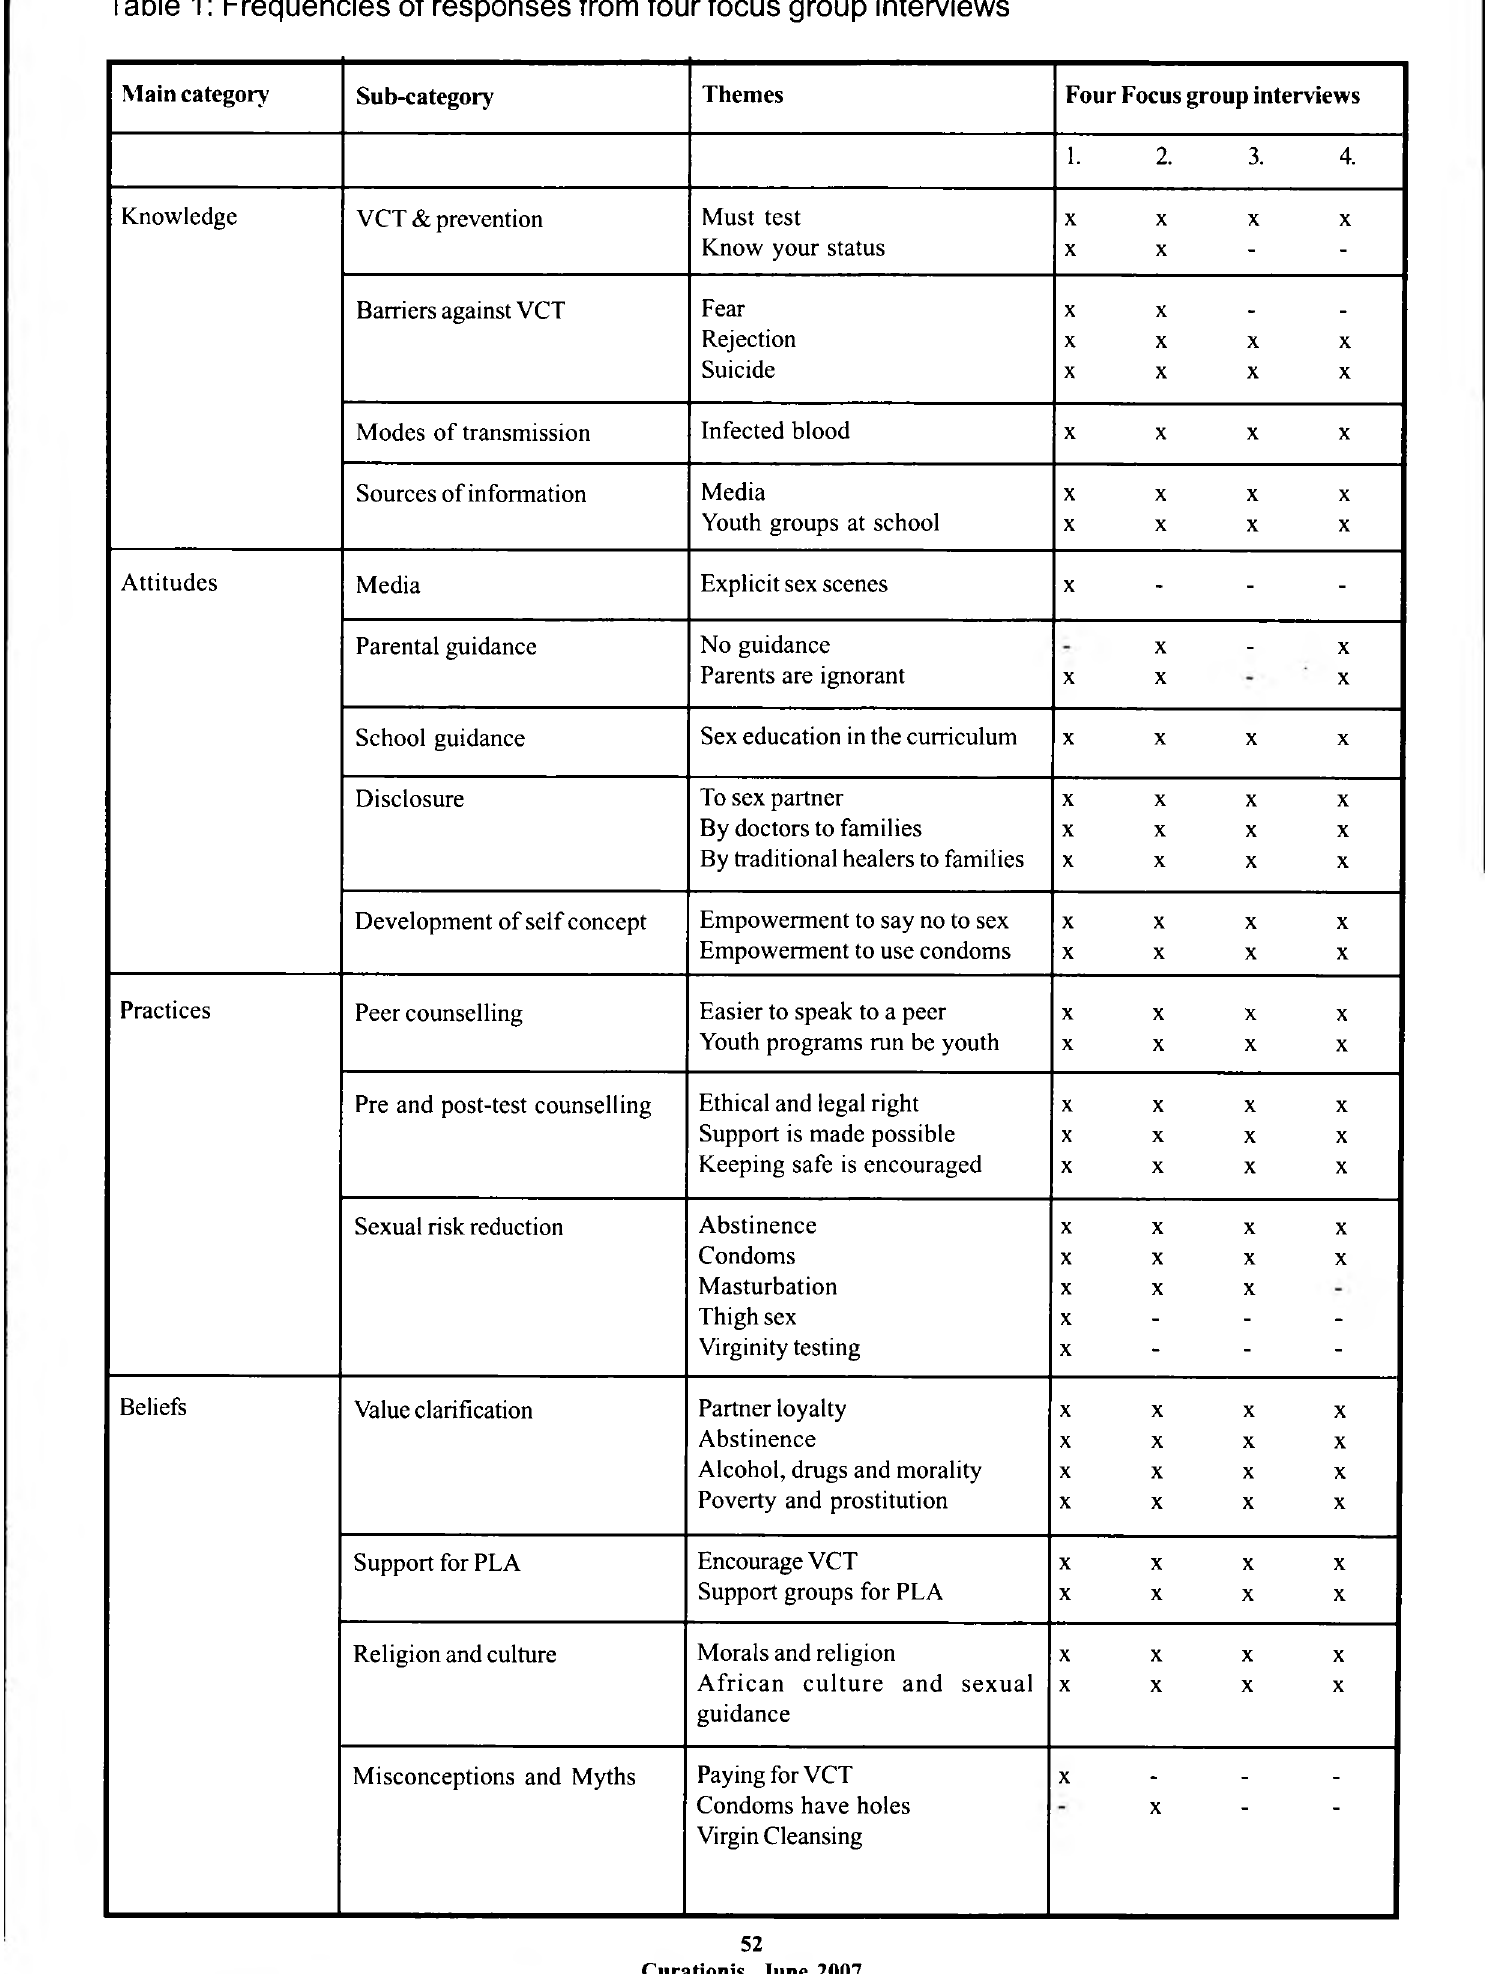
Table 1: Frequencies of responses from four focus group interviews Main